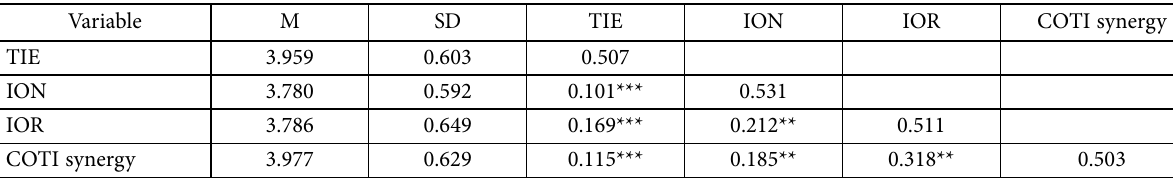
Table 2. Descriptive statistics and correlations